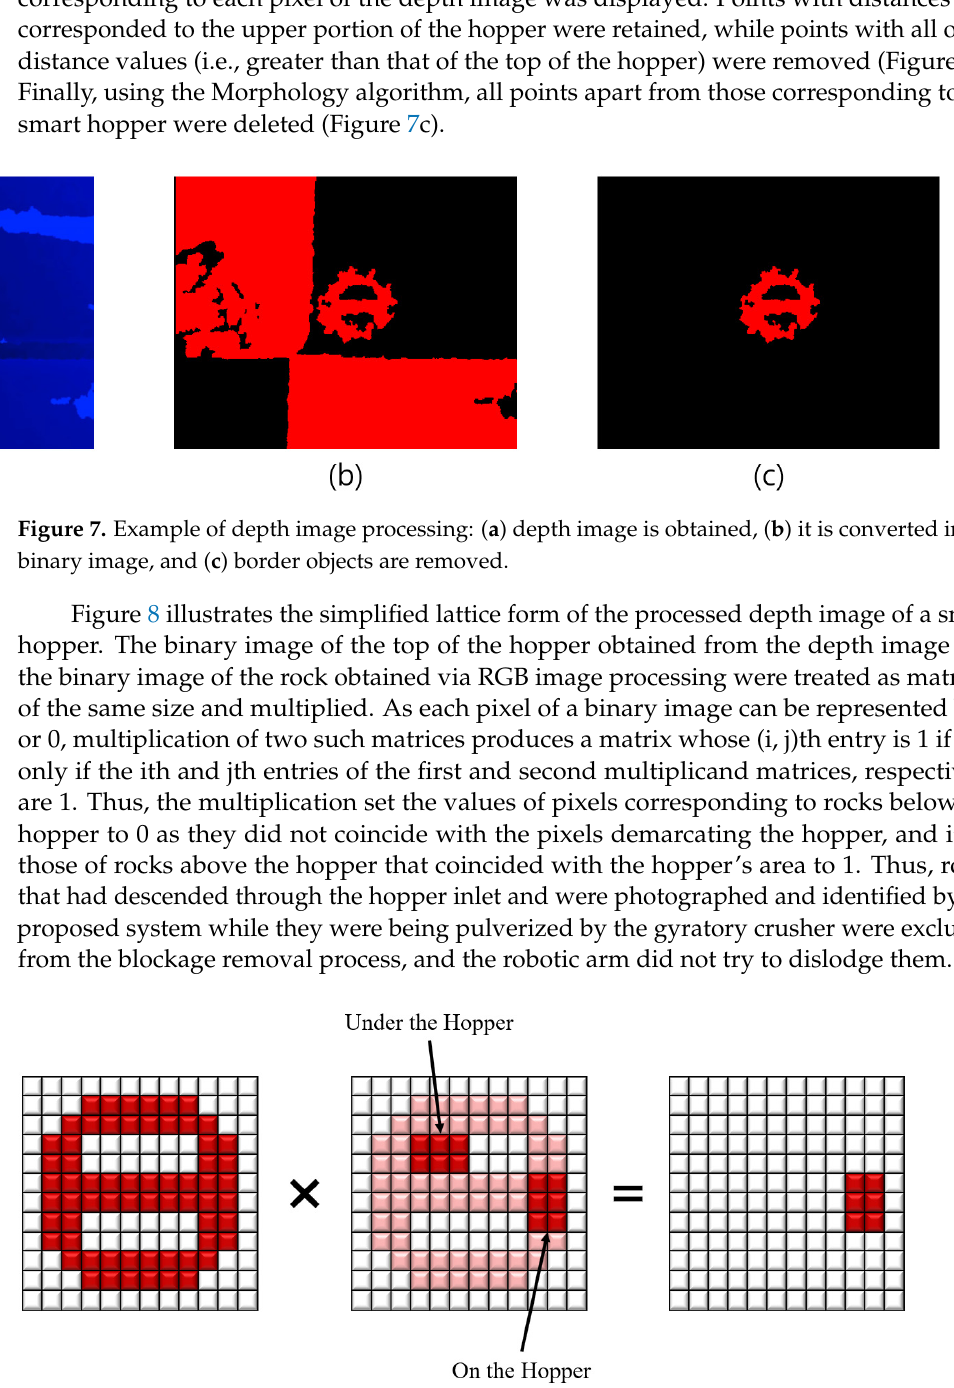
Figure 6. Example of binary image processing: ( a ) grayscale image is converted into a binary image, ( b ) low-pass filter is utilized, ( c ) small objects are removed, and ( d ) the object’s coordinates are cal- culated.